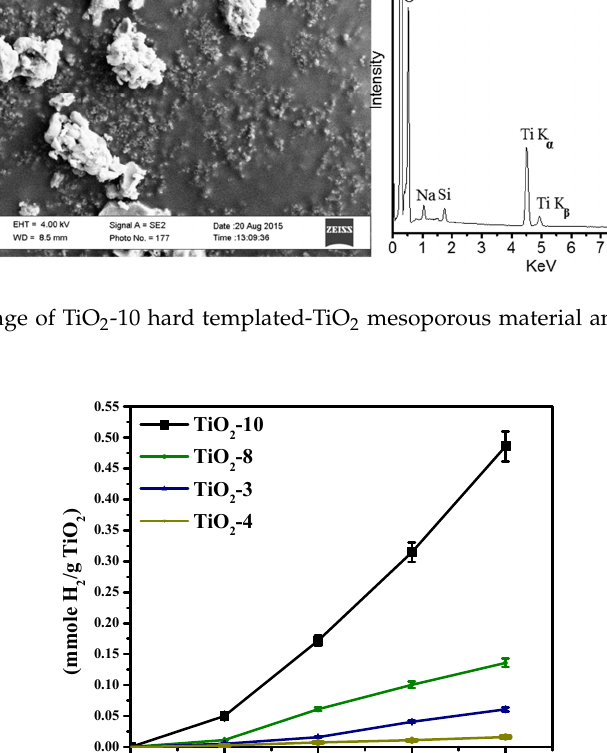
Figure 9. Hydrogen evolution from the hard templated mesoporous TiO 2 photocatalysts.